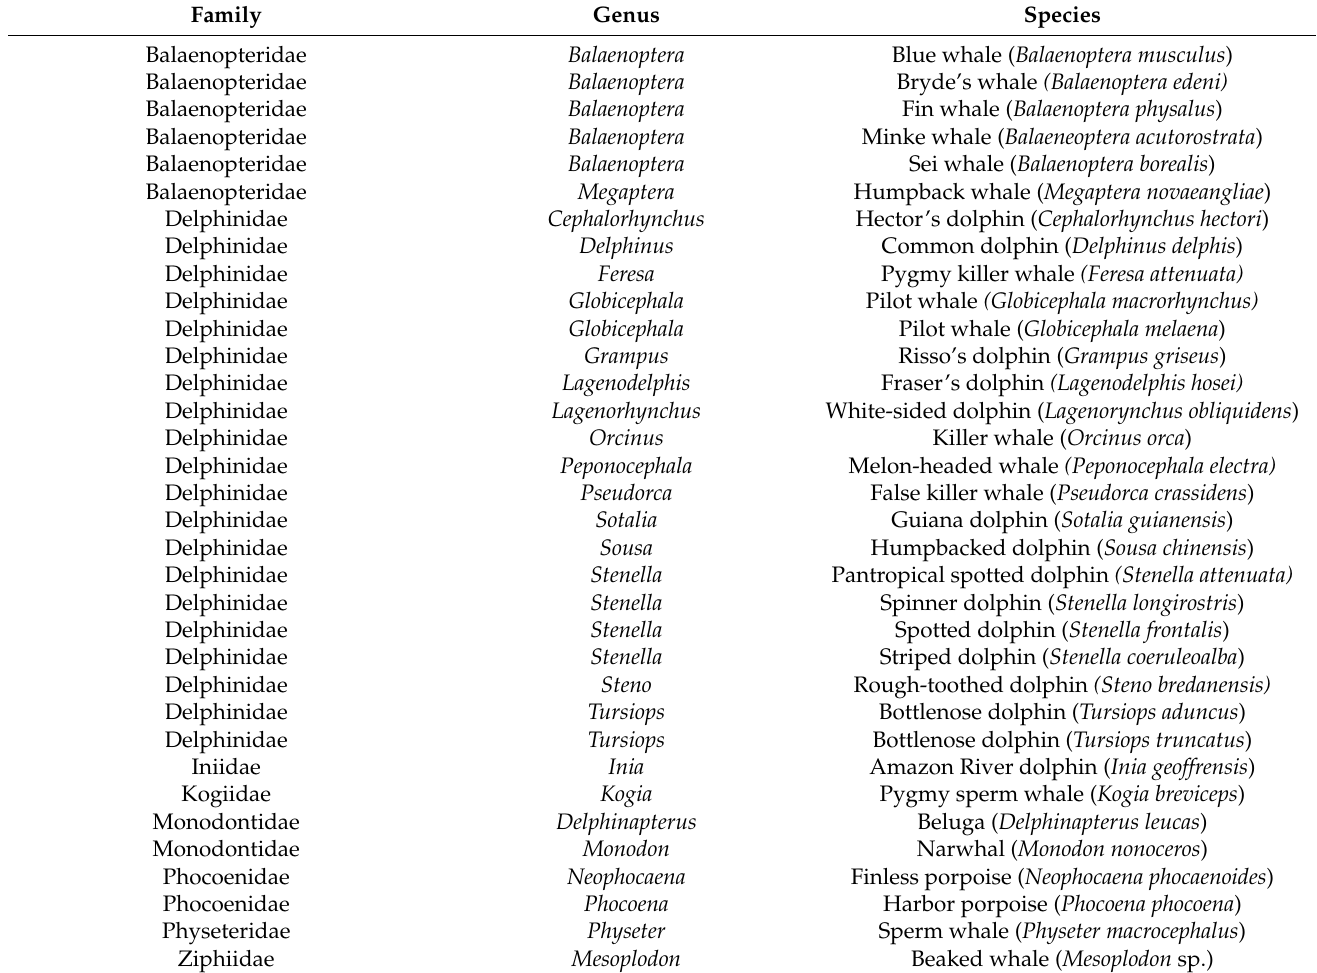
Table 1. T. gondii or T. gondii -like protozoan parasite exposure in cetaceans